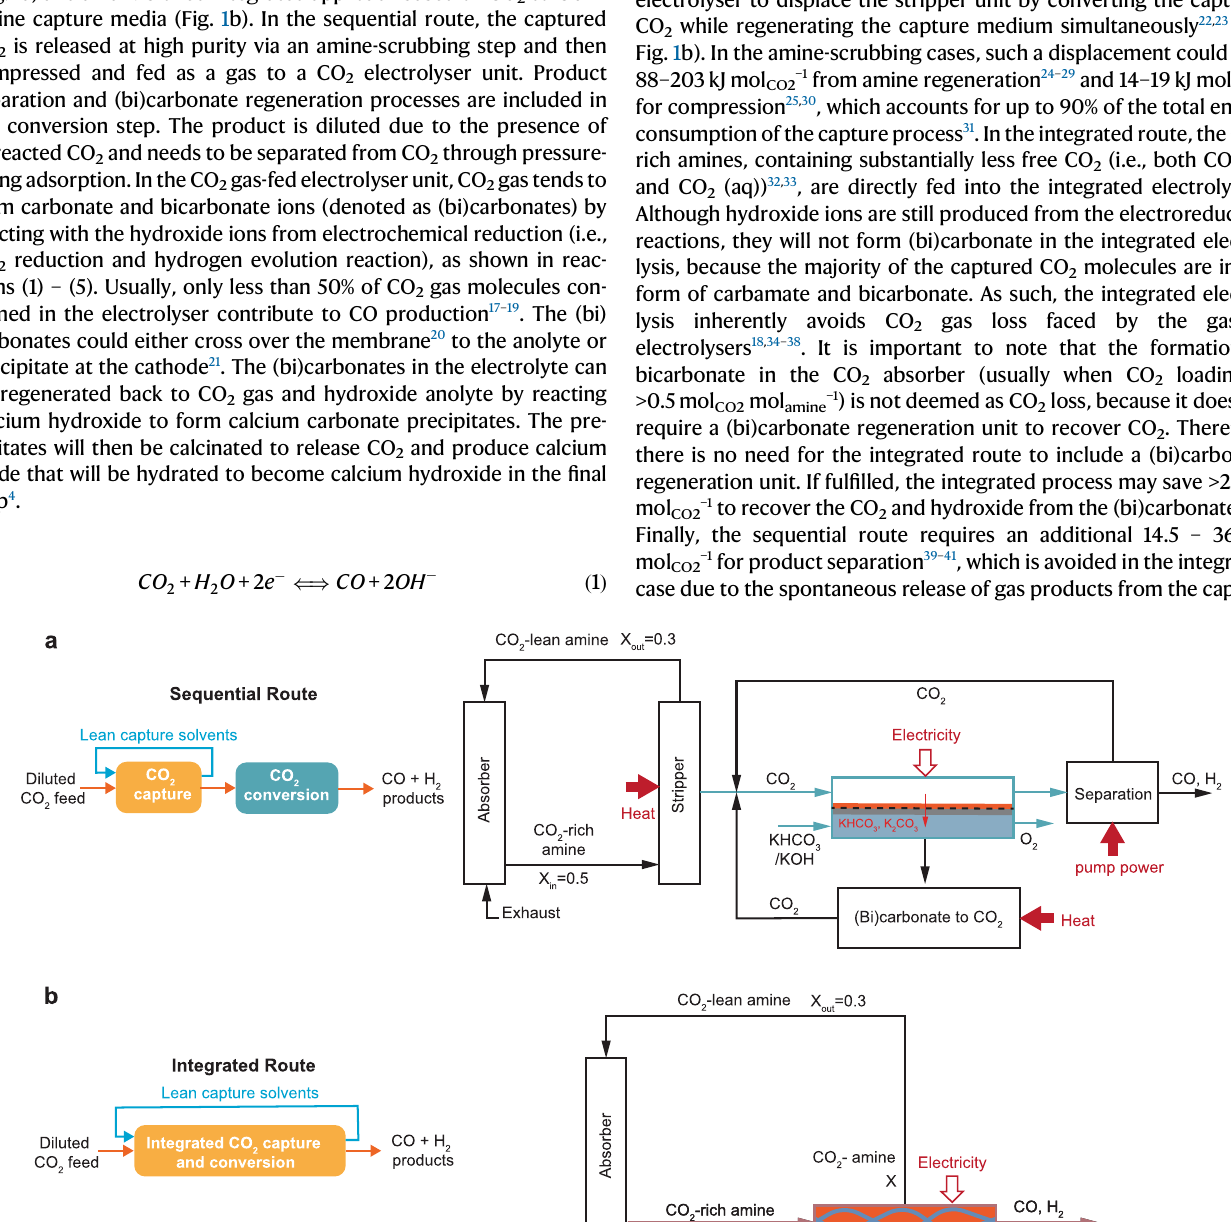
of integrated CO 2 capture and direct CO 2 electroreduction from capture medium. The compression unit between stripper and electrolyzer is not shown in the block diagram. The CO 2 loadings ofthe CO 2 -rich(X in ) and CO 2 -leanamine (X out ) streams are assumed based on Gjernes et al. report 24